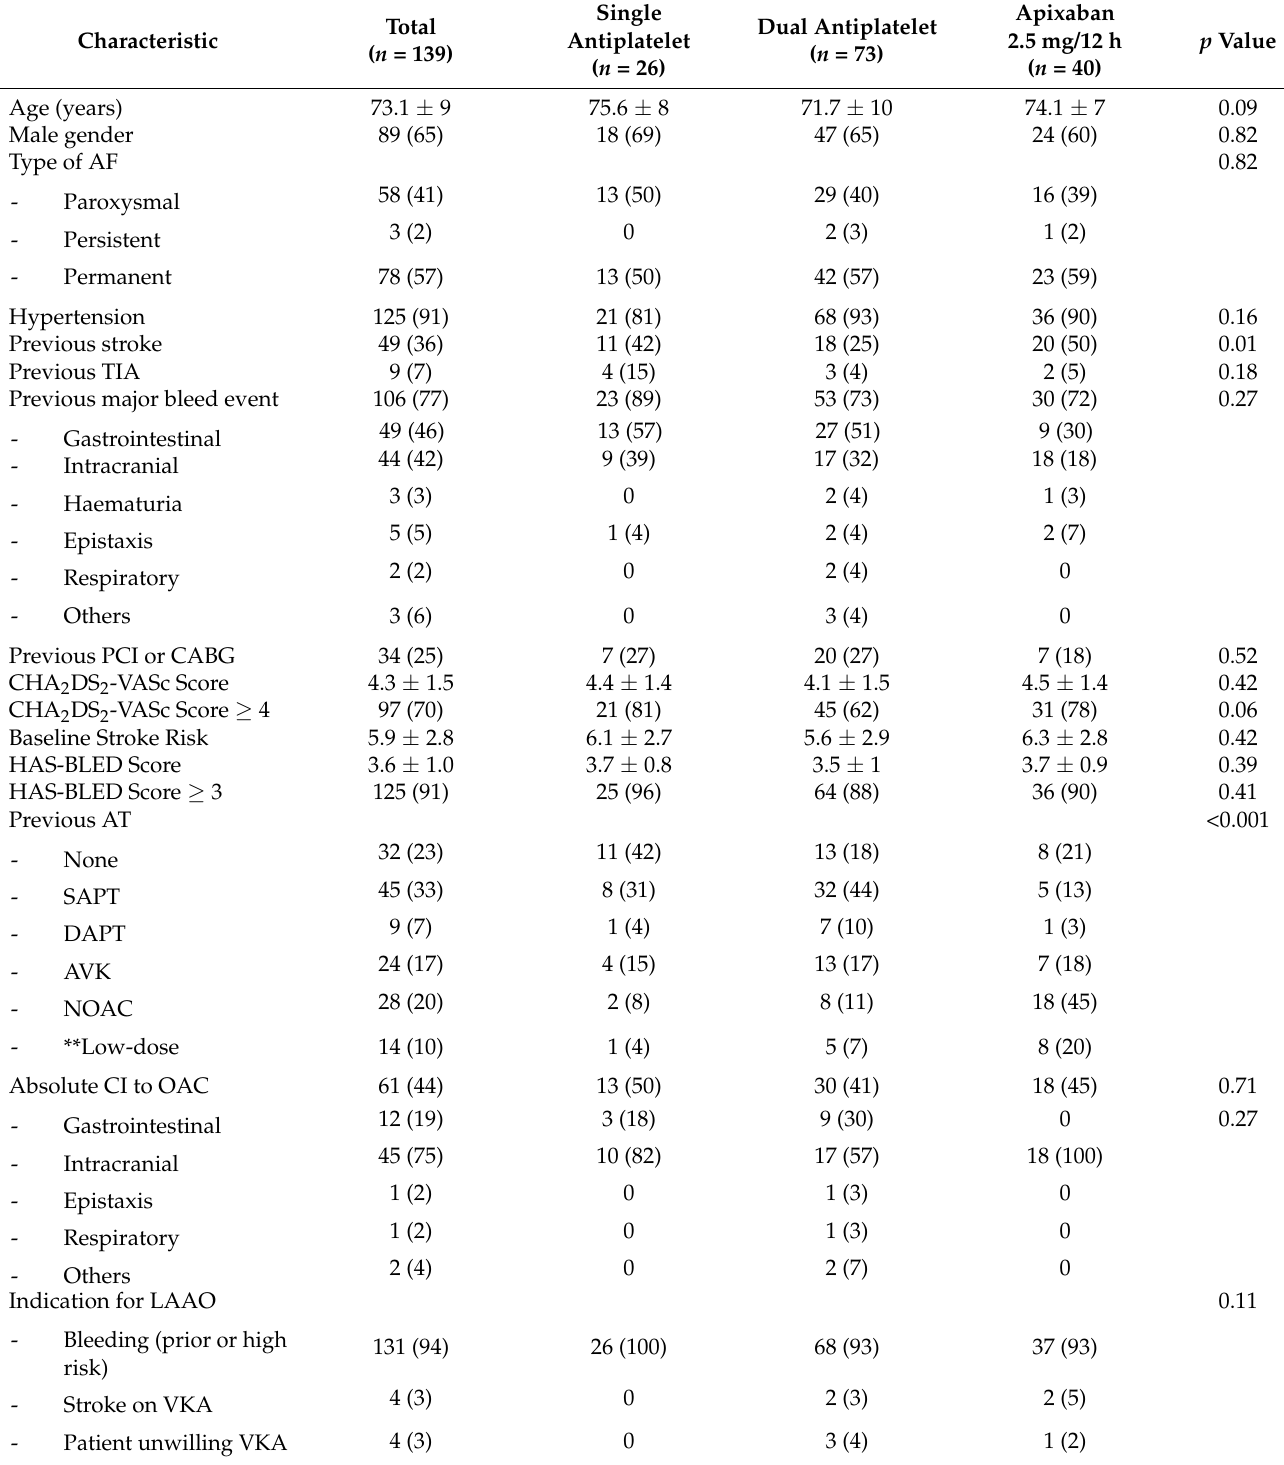
Table 1. Baseline demographics and clinical